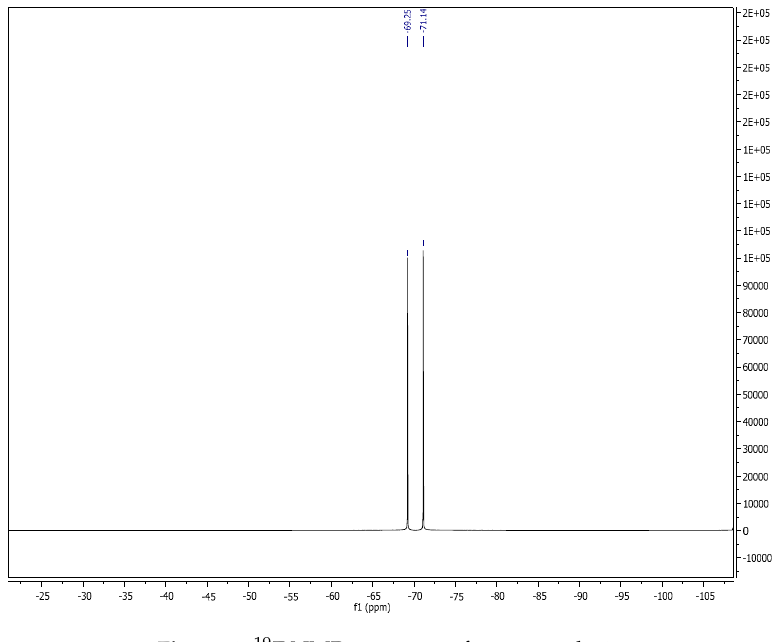
Figure 4. 19 F NMR spectrum of compound 24 .